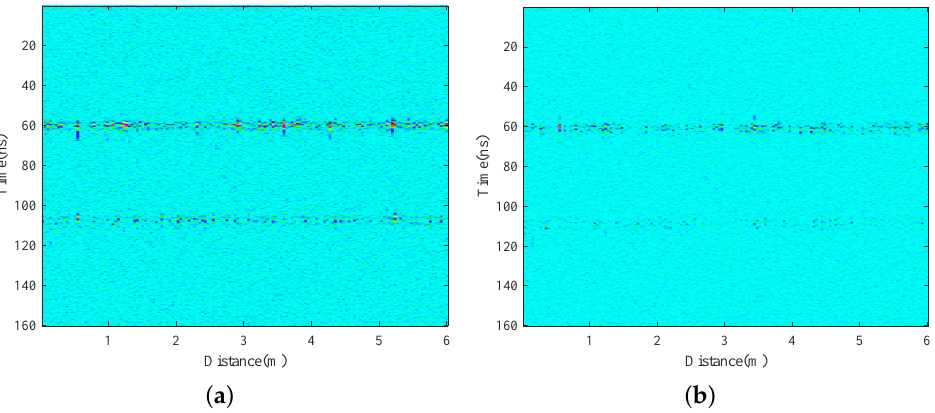
Figure 17. Simulated profiles after EMD processing. ( a ) HH polarization mode. ( b ) HV polariza- tion